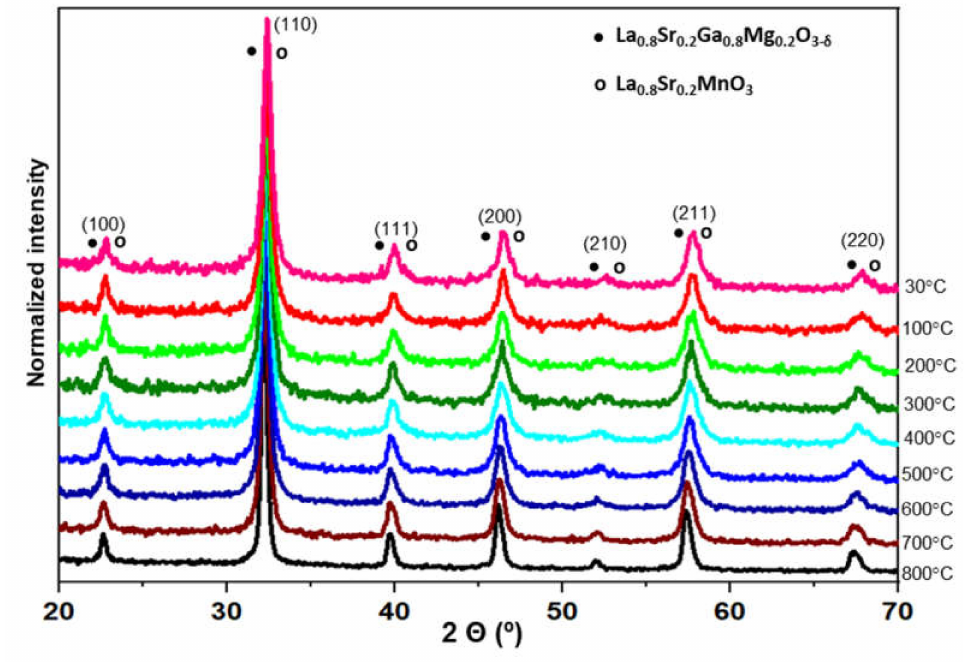
Figure 4. X-ray dynamic patterns of a LSGM / LSM powder mixture (1:1) from 30 to 800 ◦